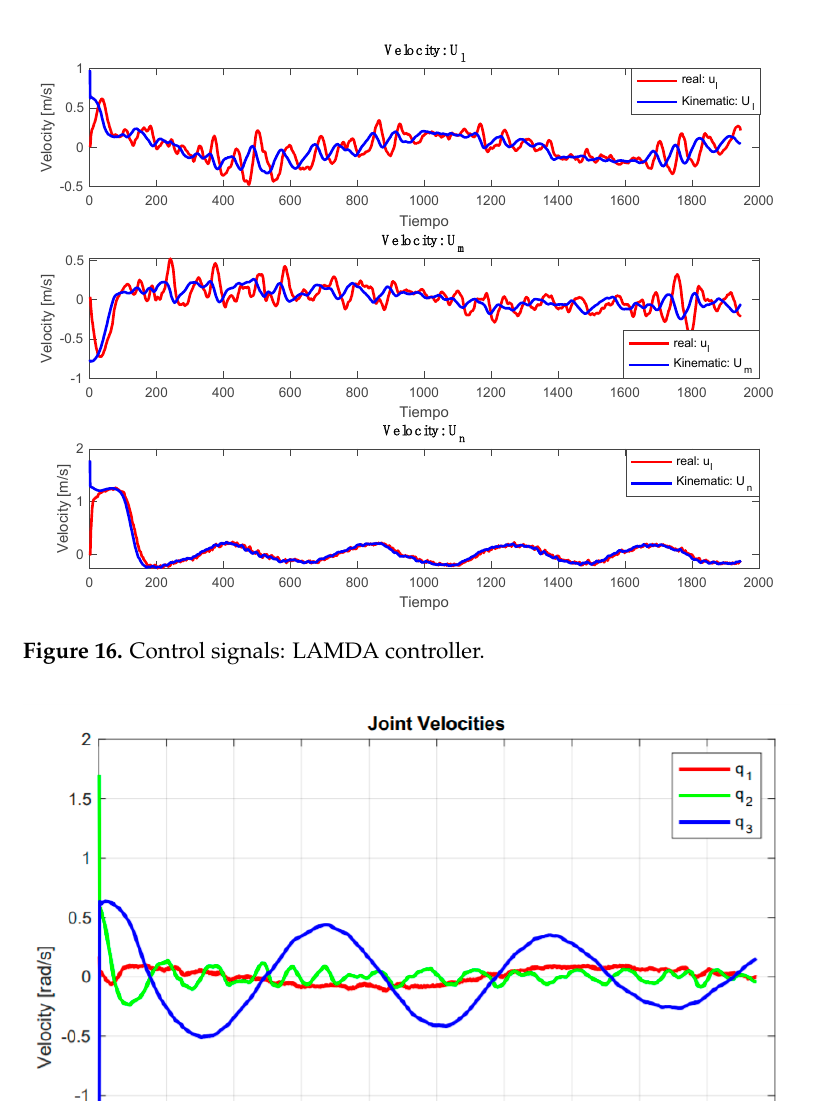
17 of 21 Figure 15. Control errors: LAMDA controller.